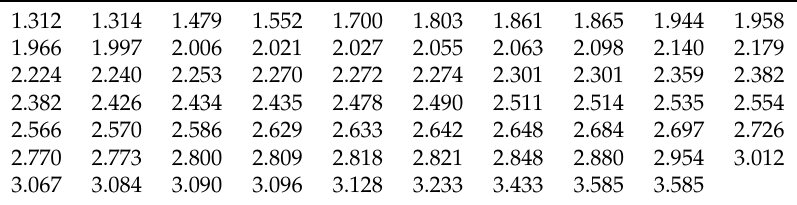
Table 3. Strength measured in GPA for carbon fibers tested under tension at gauge lengths of 20 mm.